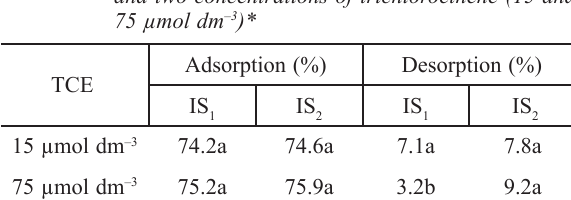
Table 3 – Trichloroethene (TCE) adsorption and desorption rates in DRL soil samples (0–34 cm) at two levels of ionic strength (IS) in the equilibrium solution and two concentrations of trichloroethene (15 and 75 µmol dm –3 )*